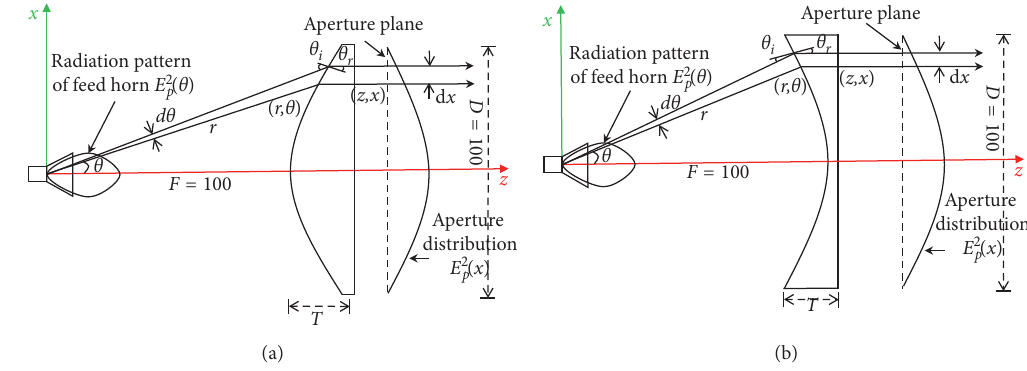
� √ 2 ), (b) Horn with NRI lens ( n � −